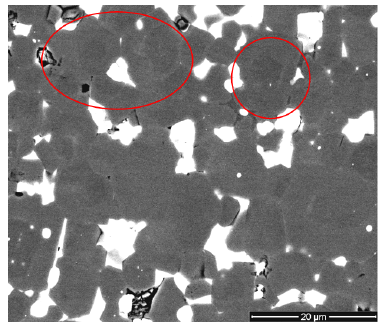
Figure 3. Microstructure (SEM image, BSED, improved contrast) of the magnet prepared by recycling magnets of two different grades.